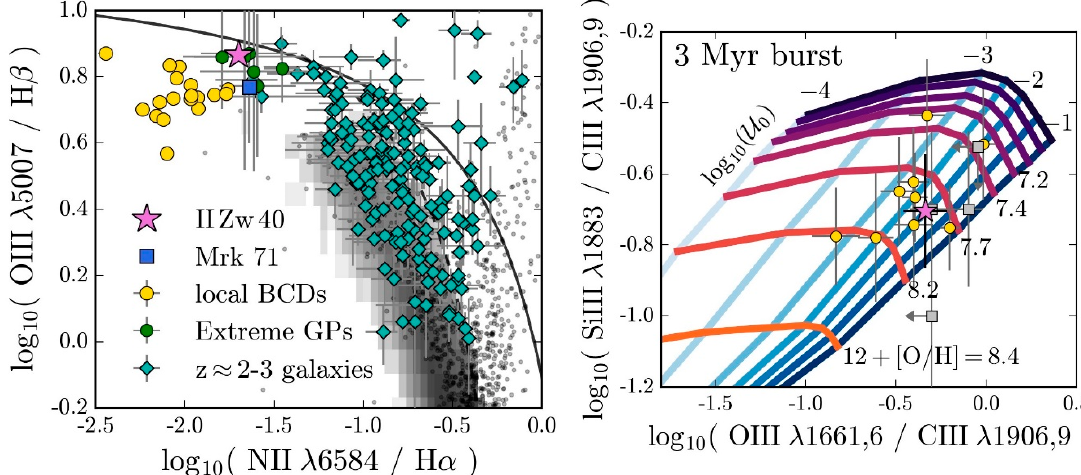
Figure 20. Left: Baldwin Phillips & Terlevich (BPT) diagram comparing II Zw 40 to other samples: the BCD sample of [30]; extreme Green Peas of [92]; Mrk 71 [93]; z ≈ 2–3 galaxies of [94]. Solid black line: an extreme starburst classification line from [95]. The grayscale 2D histogram indicates the density of star-forming galaxies in SDSS [91]. Right: the computed line ratios of Si III] / C III] versus O III] / C III], using the models of [96]. Blue lines: calculations with a constant ionization parameter, from log U 0 = − 1 (dark blue) to log U 0 = − 4 (light blue). Calculations with constant oxygen abundance are connected with lines having di ff erent colors, from dark purple to orange. II Zw 40: purple star; BCD sample of [30]: yellow circles; z ≈ 2 galaxies of [97]: grey squares. From [76].